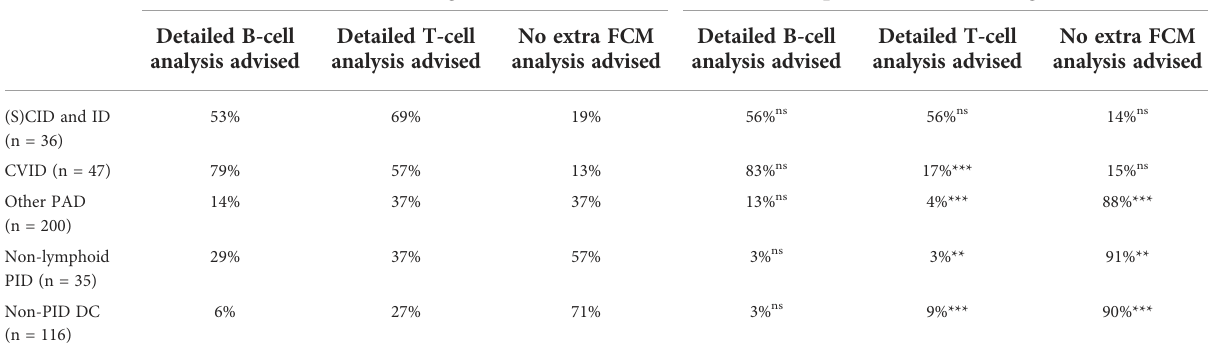
TABLE 4 Detailed follow-up FCM-based T- and/or B-cell analyses as guided by the EuroFlow PID algorithm compared to the proposed decision- tree